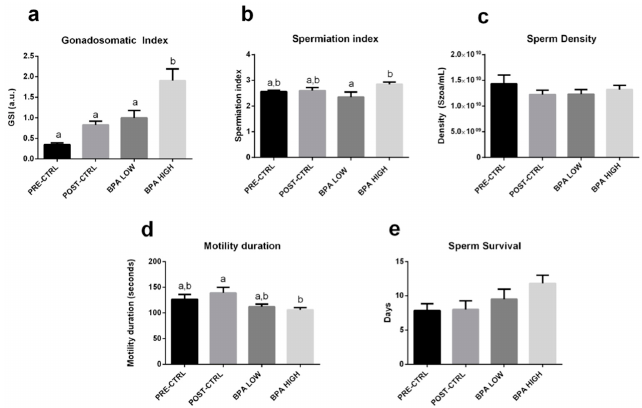
Figure 1. Mean ± SEM of gilthead sea bream ( a ) Gonadosomatic Index (GSI) ; ( b ) Spermiation index; ( c ) Sperm density (szoa / mL); ( d ) Sperm motility duration (sec); ( e ) Sperm survival (days). Letter superscripts above the means indicate significant di ff erences among treatments (one-way